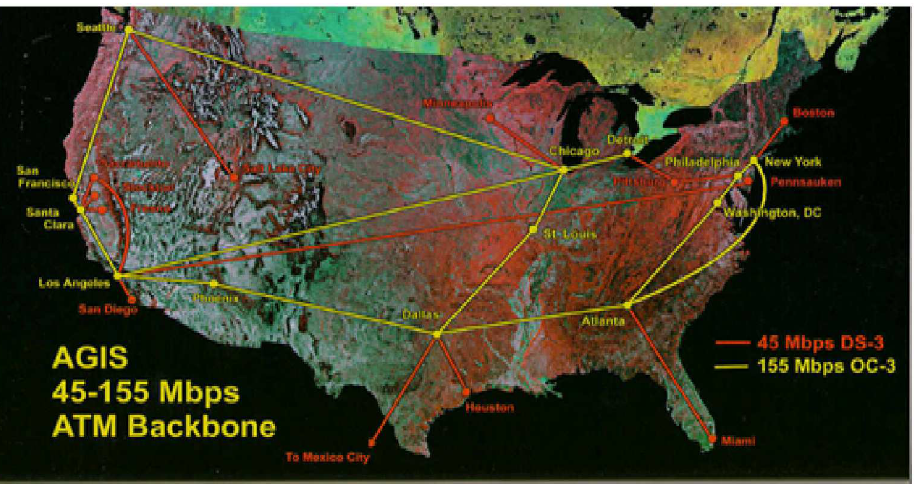
Fig 4. Agis network topology